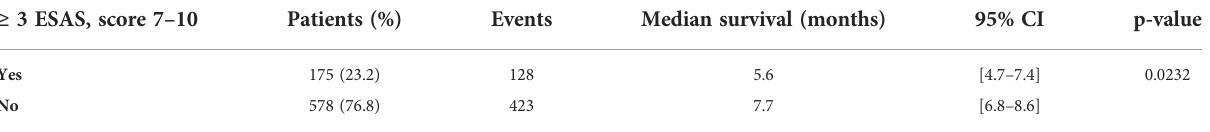
TABLE 2 Survival according to worse symptom ’ s burden by ESAS.